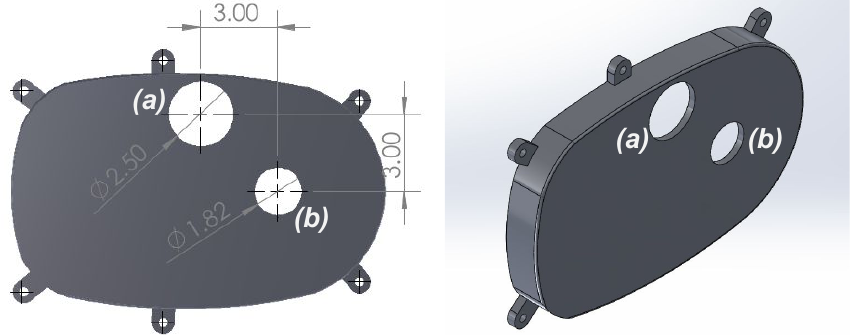
Figure 7. The steering wheel gearbox. All units are in the metric system. We made a hole ( a ) in the top center for the encoder. The hole in the right ( b ) is for the steering wheel shaft.